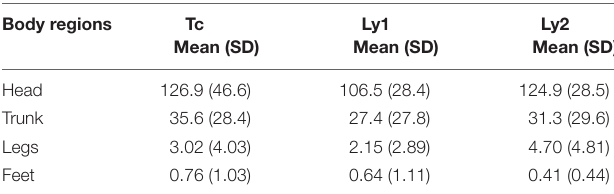
∗ p < 0.001. TABLE 1 | The average of the gaze duration in each of the four regions in